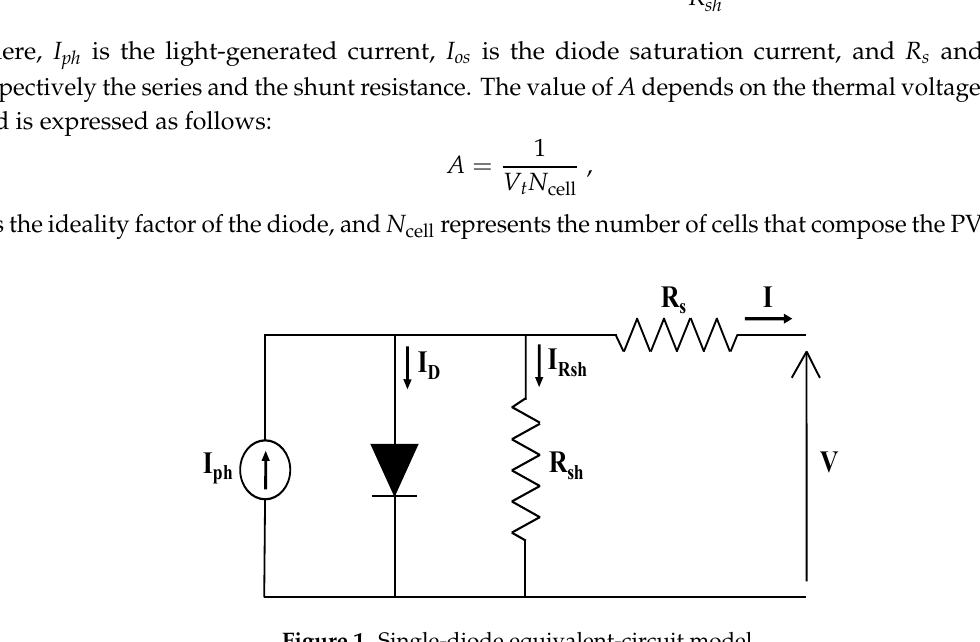
Figure 1. Single-diode equivalent-circuit model.